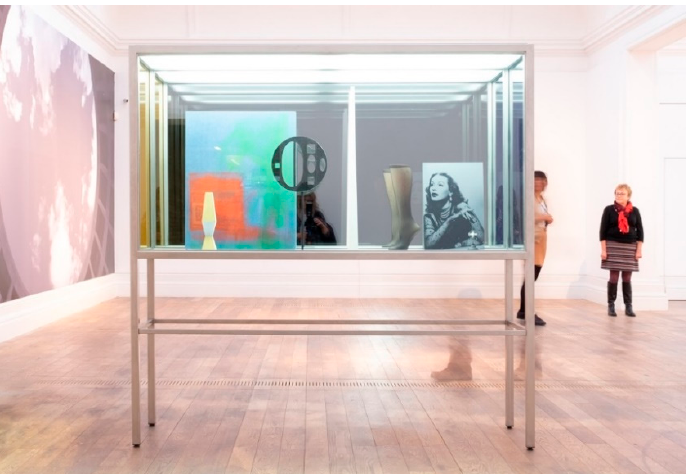
Figure 1. Josephine Meckseper. The Story of Mankind, 2014 (Installation). Mixed media in stainless steel and glass vitrine with fluorescent light and acrylic sheeting. Photo courtesy of Dilys Thompson.